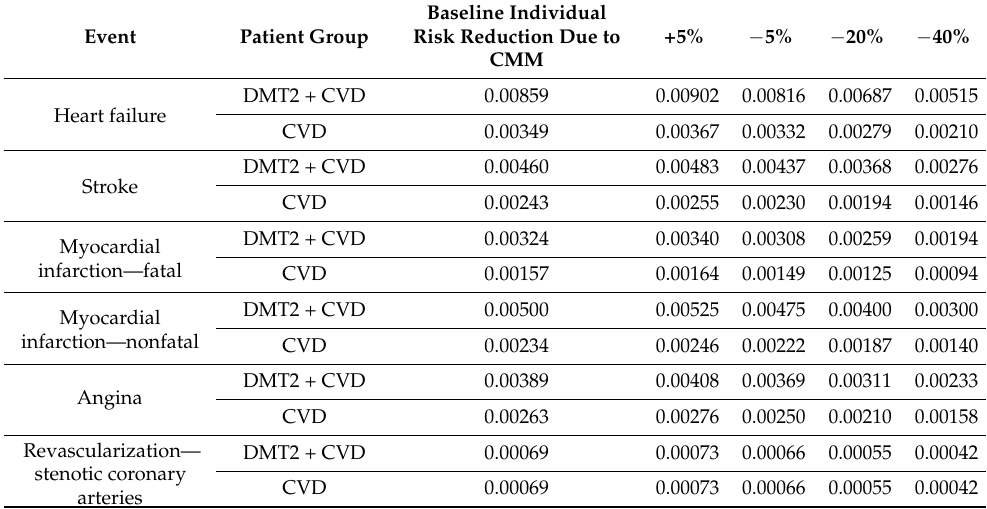
Table 8. Sensitivity analysis—risk reduction of unwanted clinical events.